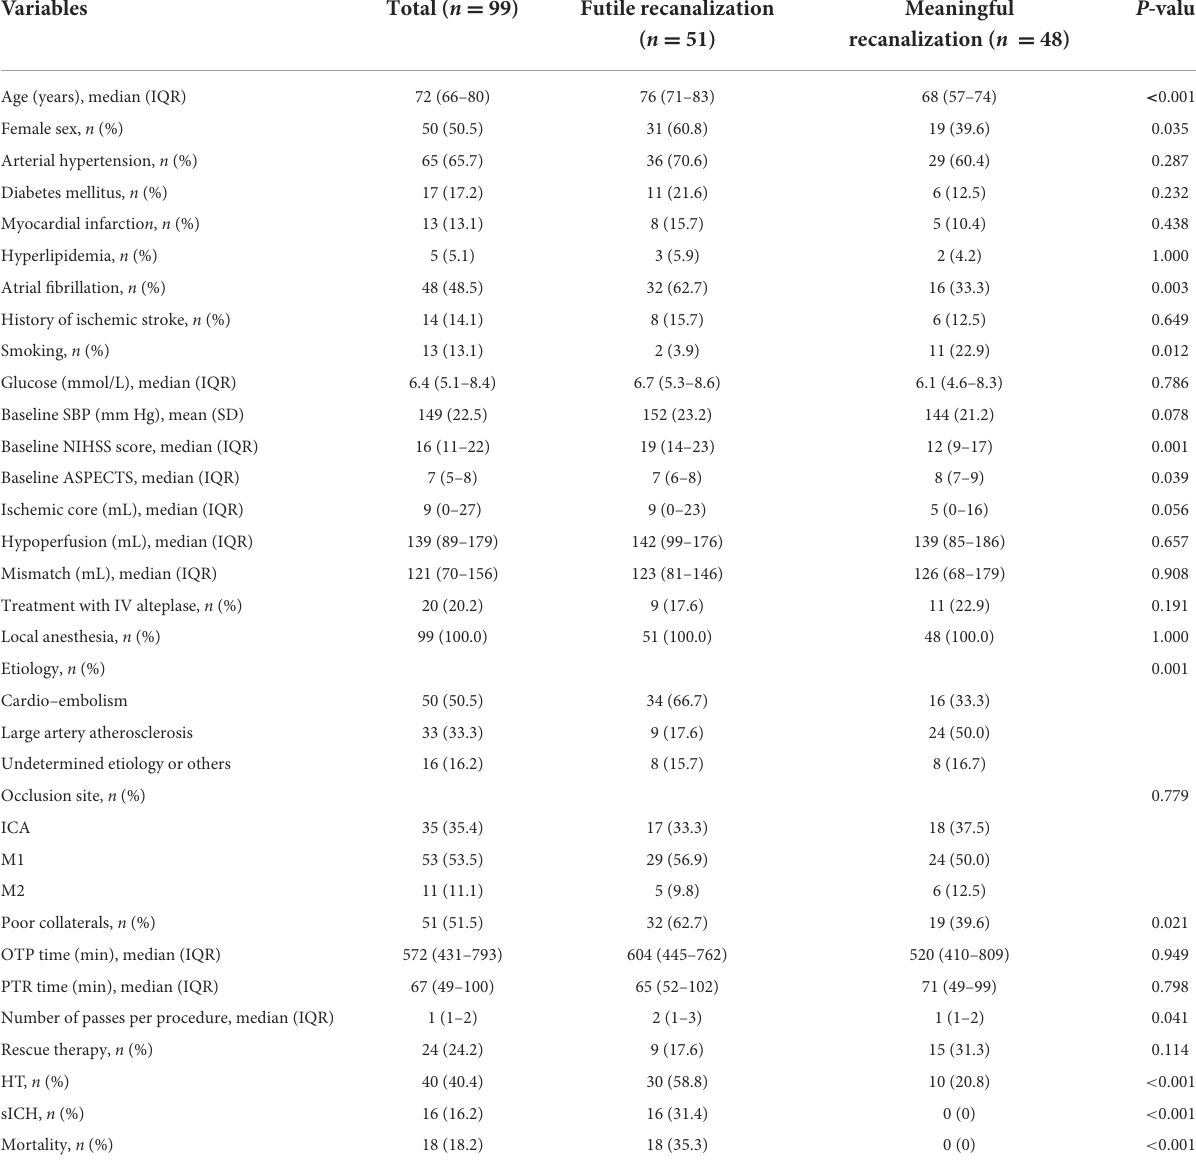
TABLE 1 Comparisons of characteristics and clinical outcomes between futile and meaningful recanalization